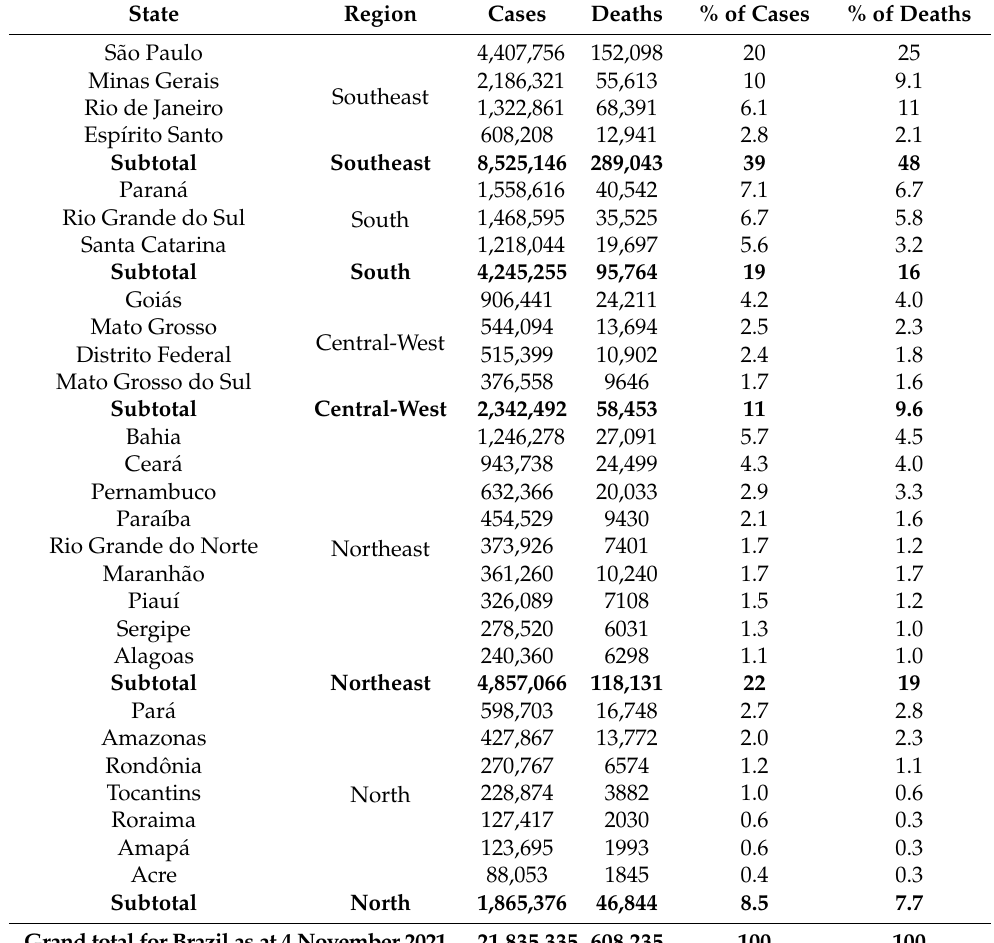
Table 1. Confirmed COVID-19 cases and deaths by state as of 4 November 2021,